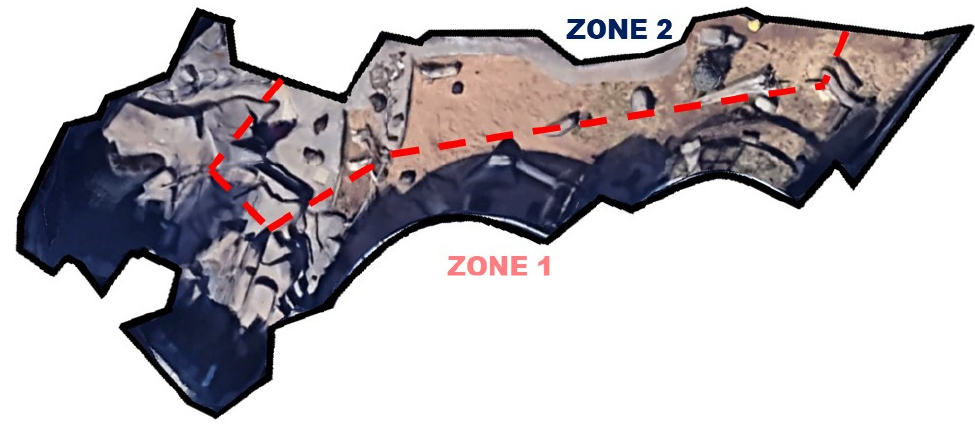
Figure 3. Map of the 762 m 2 polar bear habitat with a red line demarcating the study zones. Map of Saint Louis Zoo, Google Earth. Retrieved from earth.google.com/web/ (accessed on 20 April 2020).